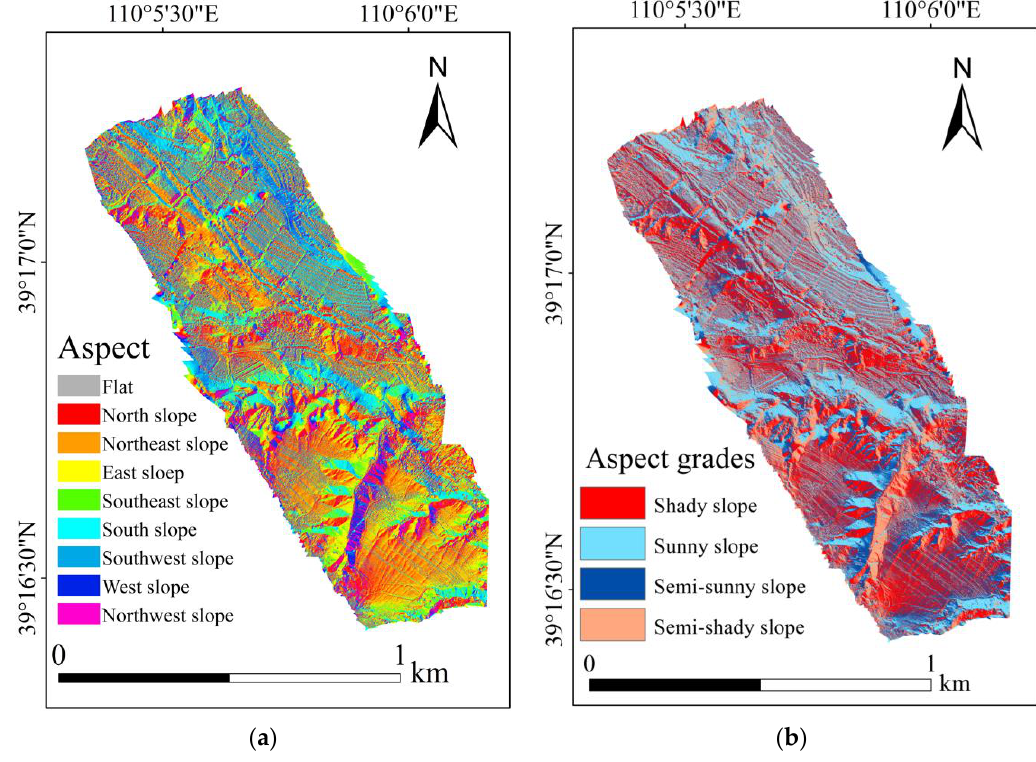
Figure 11. Aspect and grades of the study area: ( a ) aspect; ( b ) aspect grades. The slope of the study area was counted, as shown in Figure 12. The proportions of pixels for each grade of slope and aspect were counted, as shown in Figure 13.